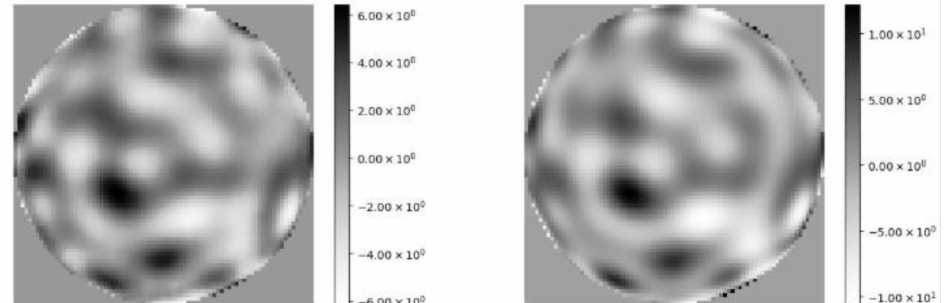
Figure 6. Comparison of a sample of the test set with r 0 of 10 cm for the FCN model for the approximation of the turbulence phase. On the left, the original reconstructed turbulence phase and, on the right, the one obtained by the FCN. In this case, although the images are quite similar, the difference in the values are higher as the tonality differs between them.